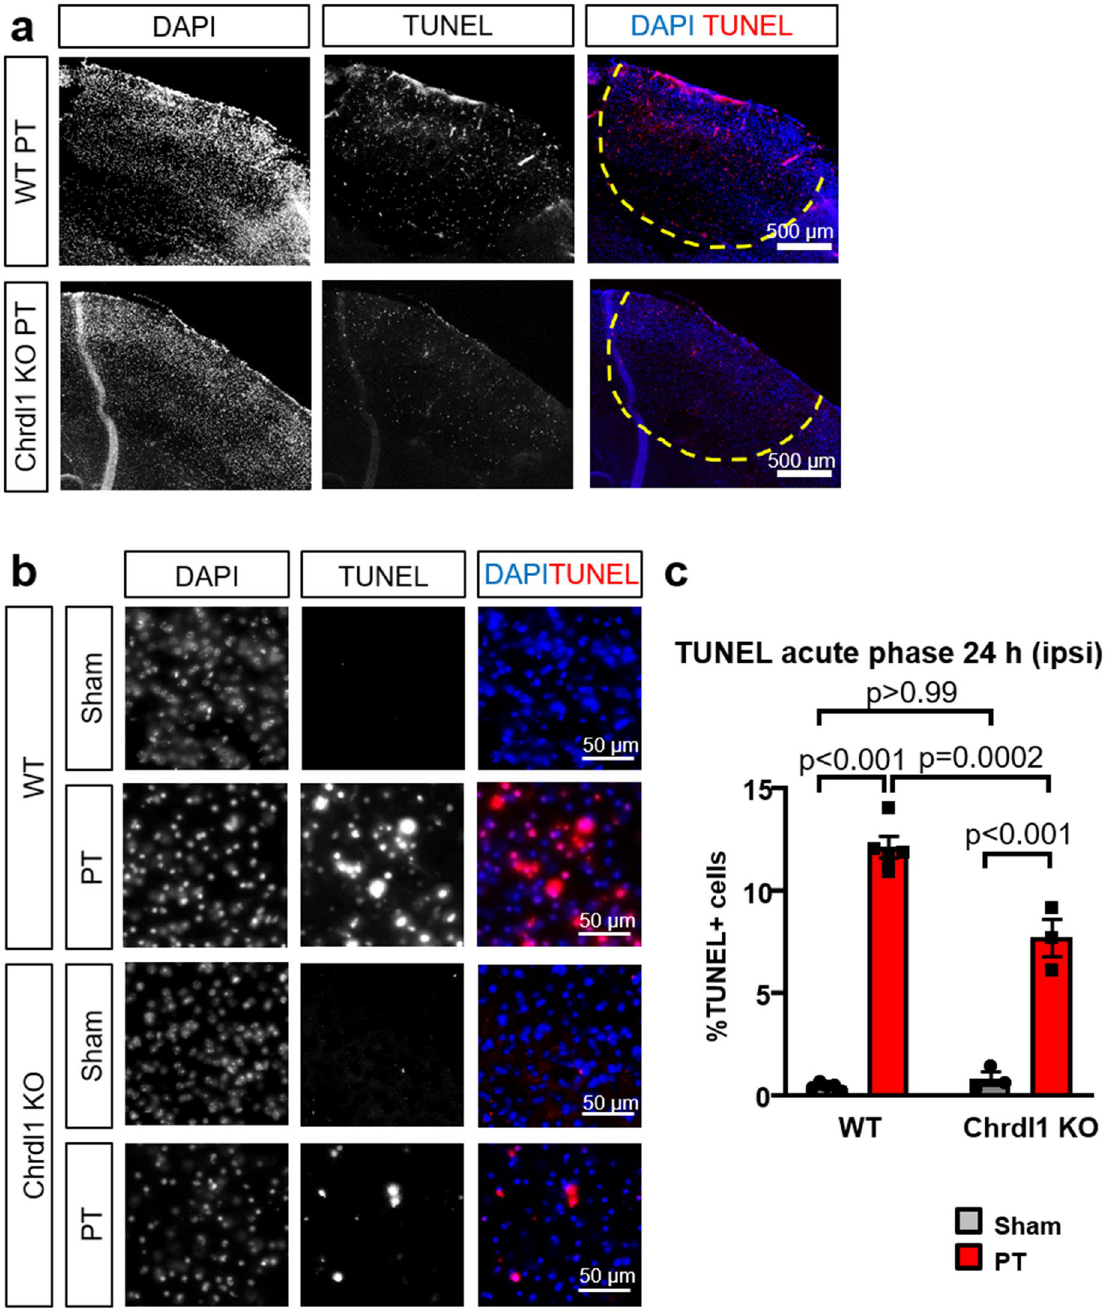
Figure 6. Cell death is reduced in Chrdl1 KO mice after PT injury. ( a ) Representative images of the upper layers of the visual cortex of a WT and a Chrdl1 KO mouse 24 h after PT showing TUNEL staining. Core of the ischemic injury is delineated by the solid yellow line. Analysis was performed in random fields of view within the core of the injury. Scale bar 500 µm. ( b ) Example images of TUNEL staining of WT and Chrdl1 KO core (ipsi) in layers 2/3 of the visual cortex. Scale bar 50 µm ( c ) Quantification of the % of cells stained with TUNEL. WT sham N = 5, WT PT N = 5, Chrdl1 KO sham N = 3, Chrdl1 KO PT N = 3 mice. Statistics by two-way phase remained low (Fig. 7i, WT sham 1.18 ± 0.13 protrusion/µm; WT PT 0.71 ± 0.08 protrusion/µm). During the sub-acute phase Chrdl1 KO mice did not experience reduction of immature spines as the density of the spines with immature morphology remained at comparable levels to the acute phase (Fig. 7i, Chrdl1 KO sham 1.16 ± 0.21 protrusion/µm; Chrdl1 KO PT 0.96 ± 0.02 protrusion/µm). There were no significant morphological changes in the contralateral hemisphere of WT or Chrdl1 KO in response to ischemic insult (Fig. S7c,d,g,h). This indicates that the absence of Chrdl1 protected the peri-infarct neurons from the typical spine loss observed in